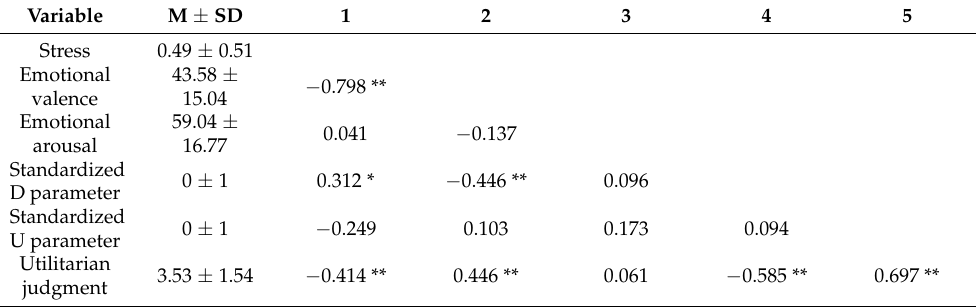
Table 2. Stress, emotional response, and moral judgment using the PD approach.